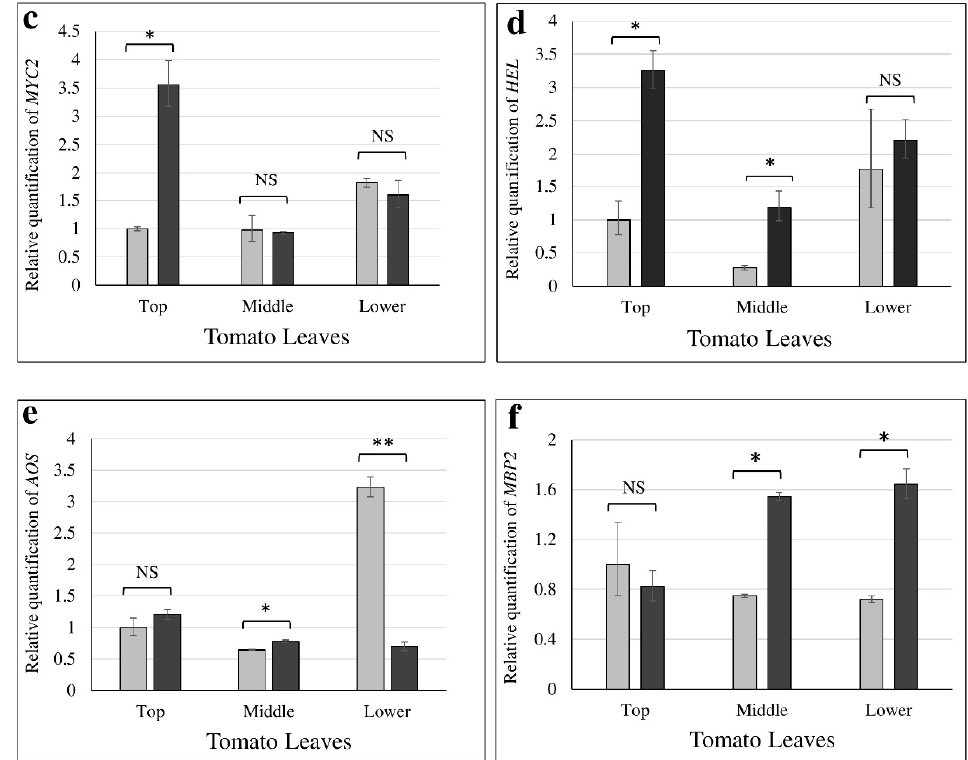
Figure 7. Quantification of defense-related genes affected by the phytophagy of N. tenuis on different strata of tomato plants. The relative quantification levels of selected defense-related genes, obtained by RT-quantitative PCR, are shown. Quantification was performed for ( a ) PI , ( b ) VSP2 , ( c ) MYC2 , ( d ) HEL , ( e ) AOS , and ( f ) MBP2 . For normalization purposes, TIP41 was used as the internal control. The 2 − ∆∆ CT method was employed for the quantification. The value obtained for top leaves of unexposed tomato plants was arbitrarily set as 1. Values for all other samples are relative to this. Results were obtained from two biological replicates. Error bars at graphs represent the standard error. Asterisks indicate that the mean expression value in plants exposed to N. tenuis is significantly different from unexposed (control) plants (* p < 0.05, ** p < 0.005, *** p < 0.001). NS indicates no statistically significant differences.